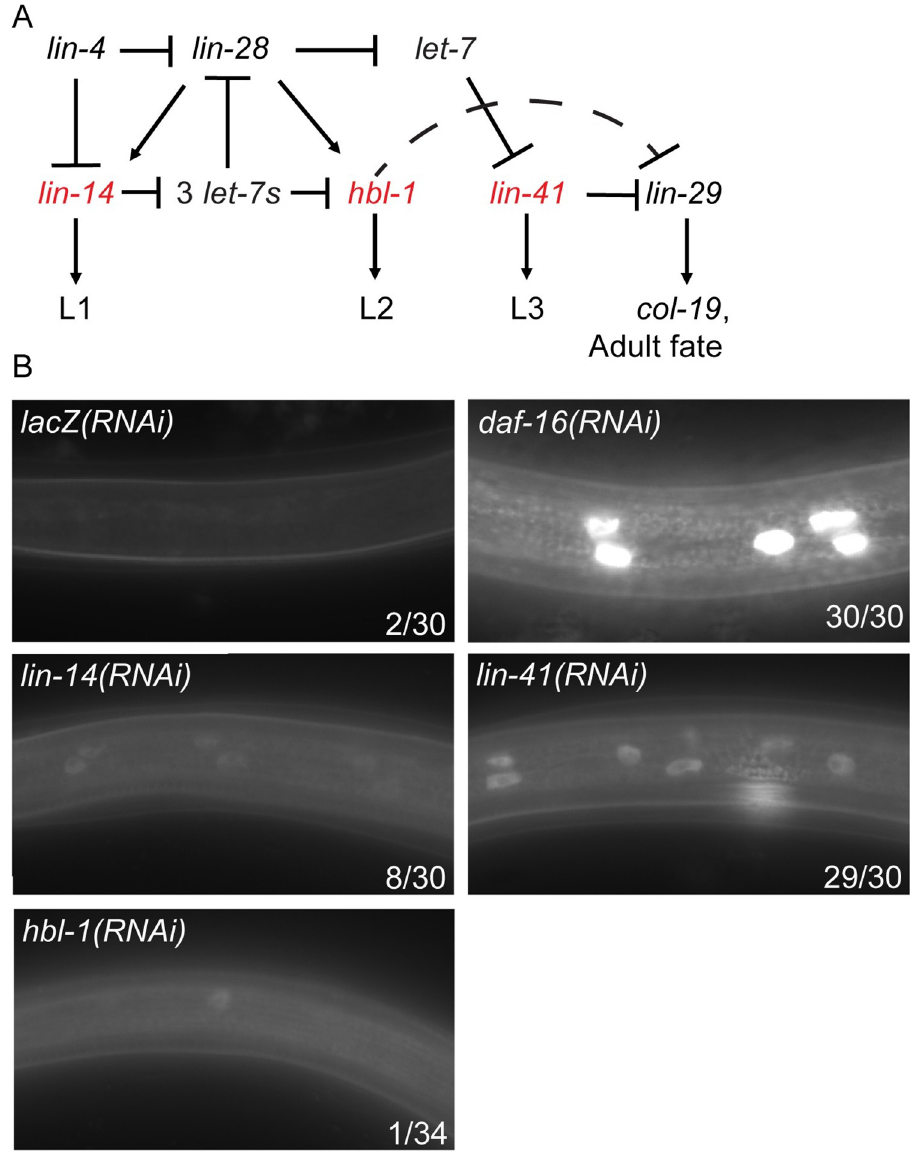
Fig 2. lin-41 is required to prevent precocious adoption of adult cell fate during dauer. (A) A simplified diagram of the network of heterochronic genes that regulates stage-specific seam cell fate during continuous development. “3 let- 7s” indicates the let-7 family members, mir-48 , mir-84 , and mir-241 . Genes in red are the most downstream positive regulators of larval cell fates [25]. (B) Precocious hypodermal expression of col-19p :: gfp in dauer larvae in response to RNAi of heterochronic genes compared to the lacZ and daf-16 RNAi controls. Images were taken with a 63x objective. Numbers indicate the number of larvae expressing any hypodermal col-19p :: gfp over the total number of dauer larvae scored. lin-14 RNAi induced only dim expression of col-19p :: gfp , at low penetrance. hbl-1 RNAi did not induce hypodermal expression of col-19p :: gfp . lin-41 RNAi caused highly penetrant expression of col-19p :: gfp during dauer. expression to block col-19p :: gfp and adult cell fate, and that in daf-16(-) dauers, lower levels of lin-41 lead to precocious col-19p :: gfp expression. To test whether reduced lin-41 levels are required for precocious col-19p :: gfp expression in daf-16(0) dauers, we performed daf-16 RNAi on a strain in which lin-41 is misexpressed. To do this, we took advantage of the lin-41(xe8[ Δ 3’UTR]) allele which prevents the normal